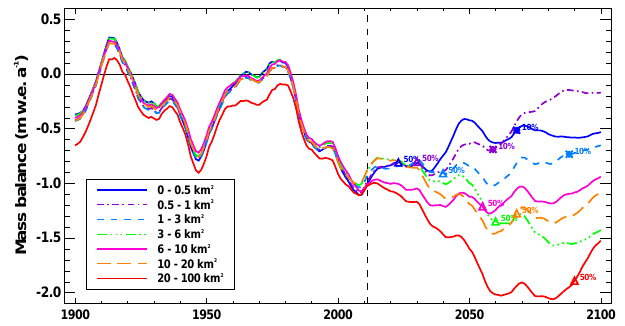
Fig. 6. Mass balance series (11-yr low pass filtered) of different glacier size classes (European Alps, 1900–2100). Attribution to size classes is relative to 2003. Future simulations refer to RCP6.0. Tri- angles (asterisks) indicate the date when area of the respective class has decreased to 50% (10%) of the 2003 extent.